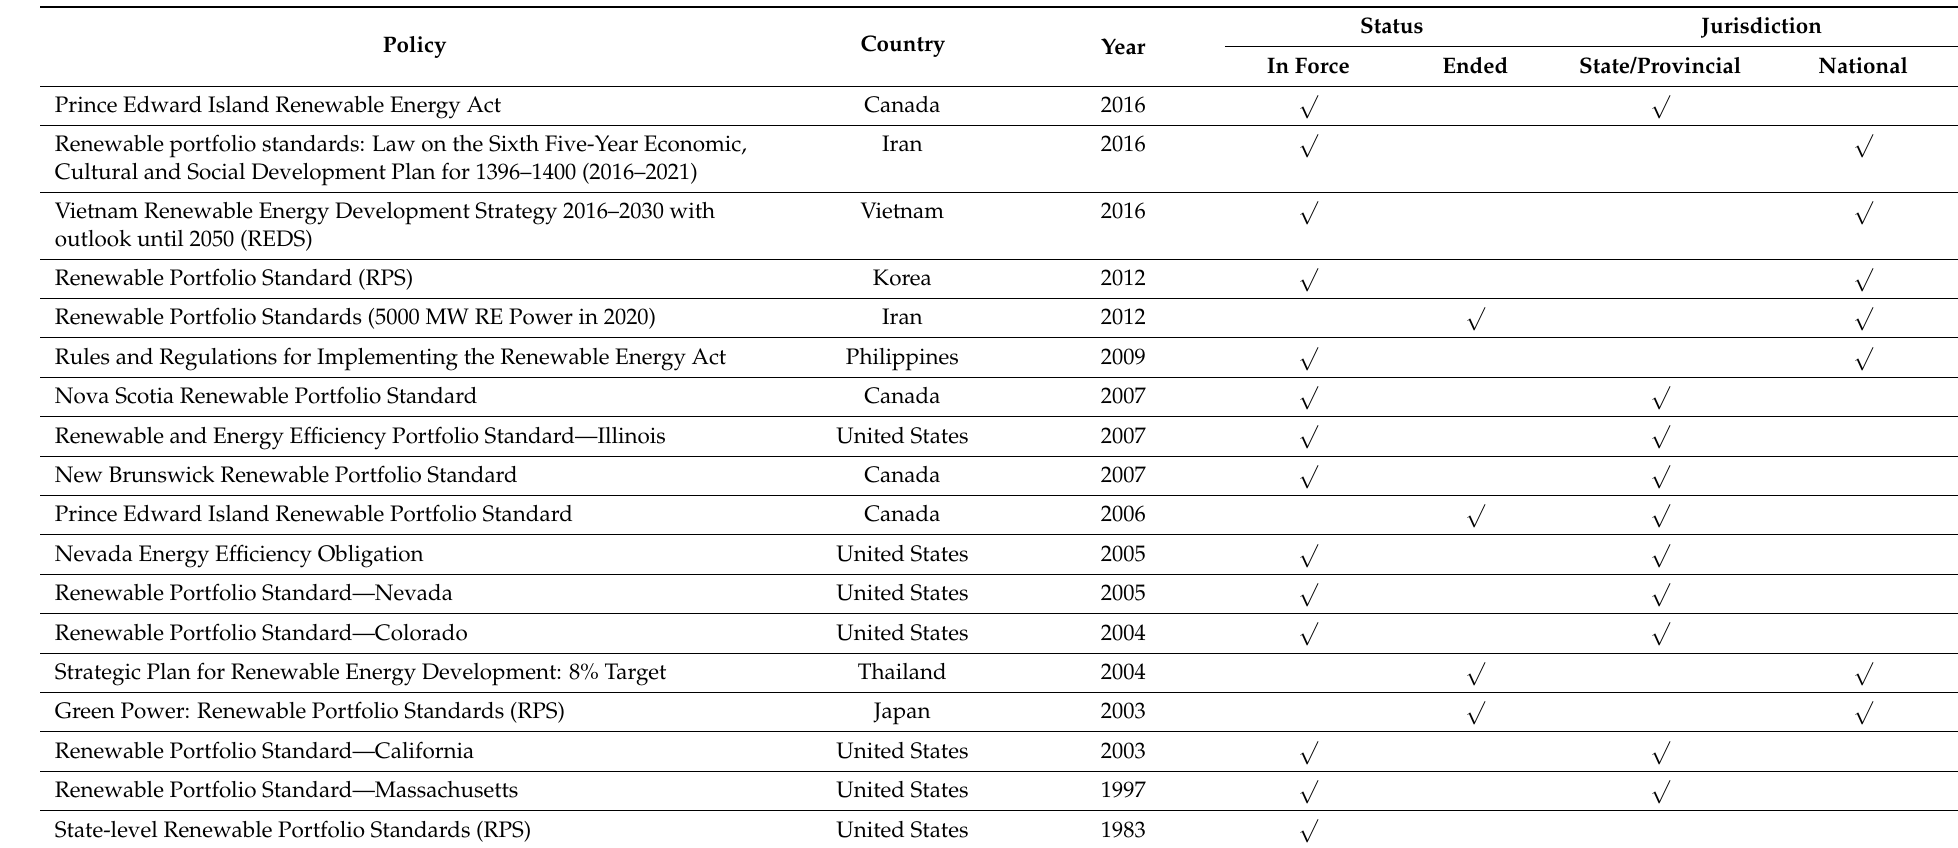
Table 4. Worldwide RPS standards and their